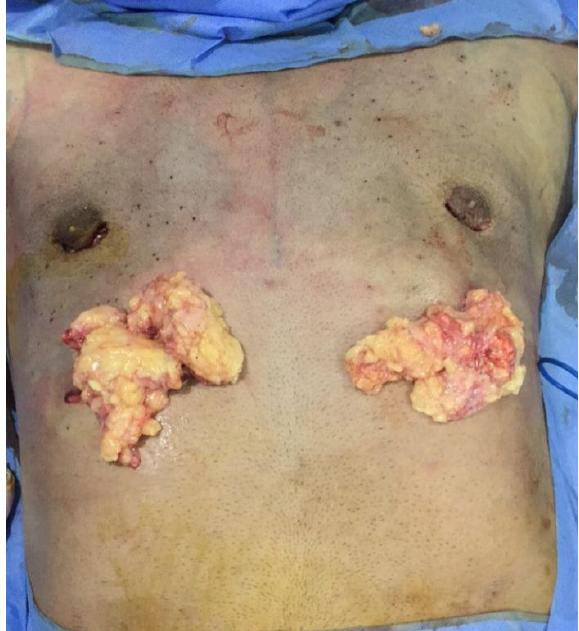
Figure (4) Debunking by fine scissor and then undergo waffle like cutting under surface.